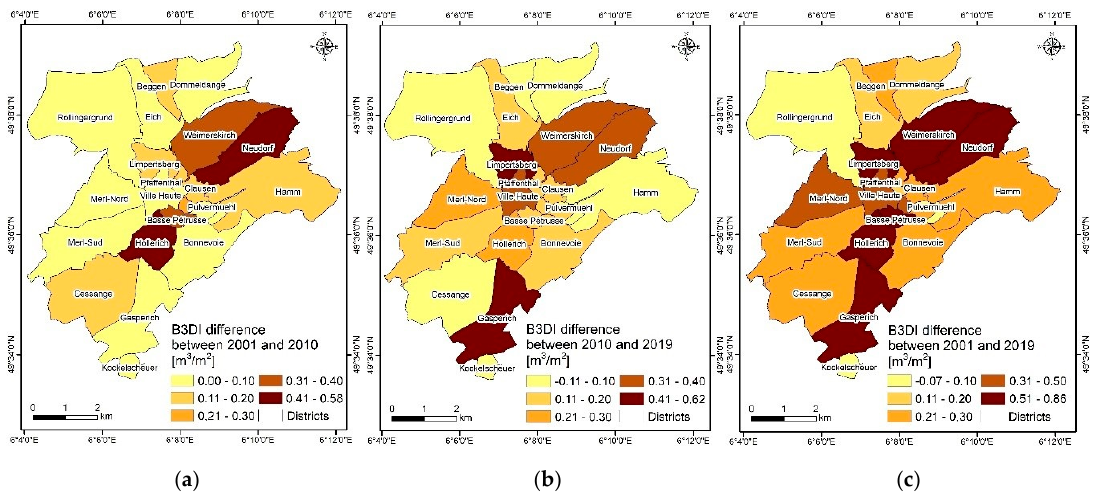
Figure 15. Changes of the B3DI index in Luxembourg City districts over the last 20 years; differences between 2001–2010 ( a ); 2010–2019 ( b ); between 2001–2019 ( c ).